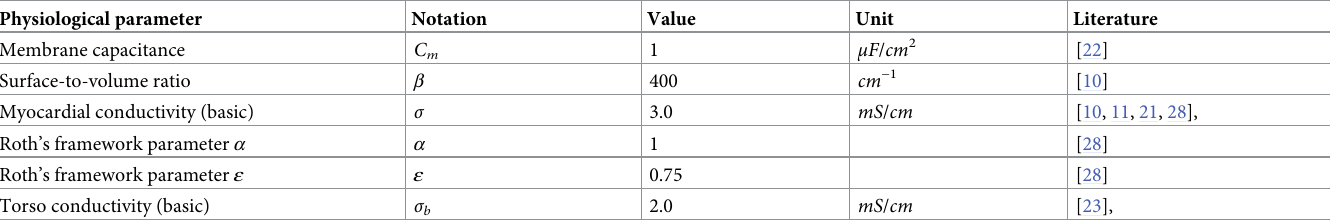
Table 2. Model parameters that were not varied in the experiments. Physiological